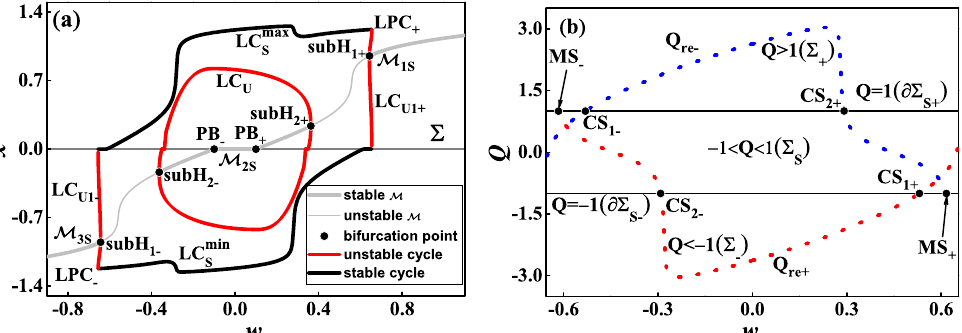
Figure 3. One parameter bifurcation diagram of the fast subsystem in the ( w , x ) plane: ( a ) is the attractor and their stabilities with sliding bifurcations of LC S presented in the return map ( b